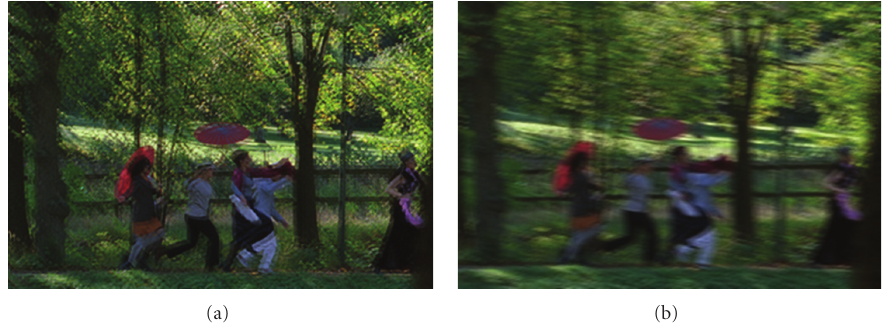
Figure 13: A region of ParkJoy , frame no. 117, 4 × slow motion, coded by Fractal (a) and Cubic Spline (b) interpolation.